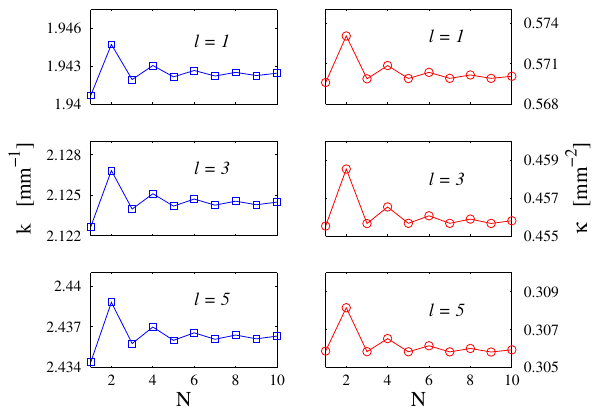
FIG. 2. Wave number (left) and loss factor (right) conver- gence versus N for l ¼ 1 ; 3 ; 5 . The corresponding matrix size is 2 ð 2 N þ 1 Þ